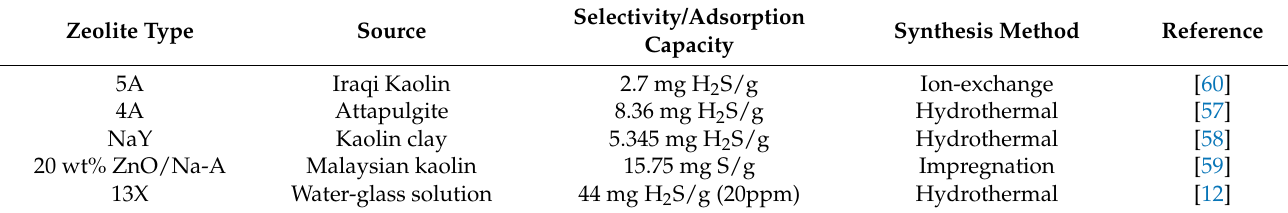
Table 6. Studies on synthetic zeolitic adsorbents from various